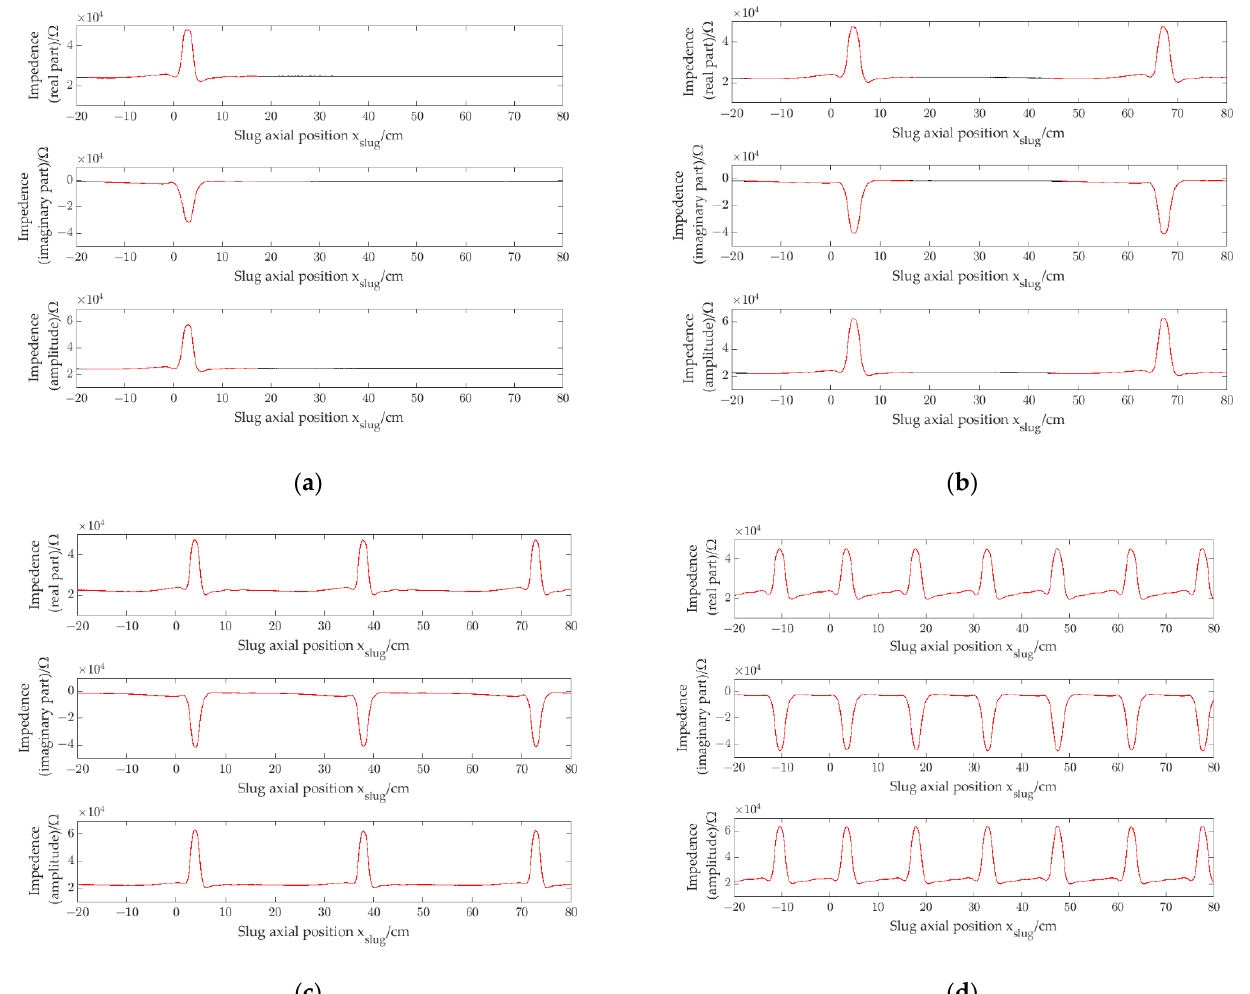
Figure 13. Impedance signals of slug flow, i.d. = 3.54 mm: ( a ) single slug; ( b ) signal separation distance is 63 cm ( ρ re = 0.93, ρ im = 0.94 and ρ am = 0.93); ( c ) signal separation distance is 34 cm ( ρ re = 0.95, ρ im = 0.97 and ρ am = 0.95); ( d ) signal separation distance is 14 cm ( ρ re = 0.43, ρ im = 0.46 and ρ am =